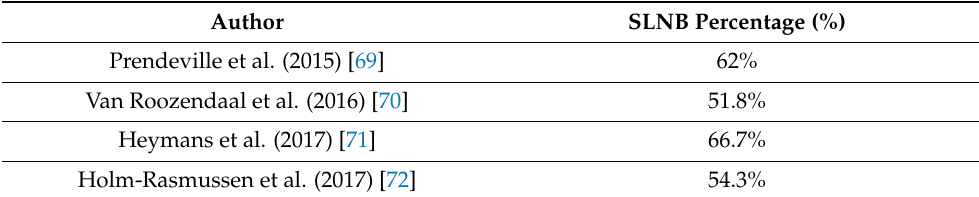
Table 11. Literature review—sentinel lymph node biopsy (SLNB)